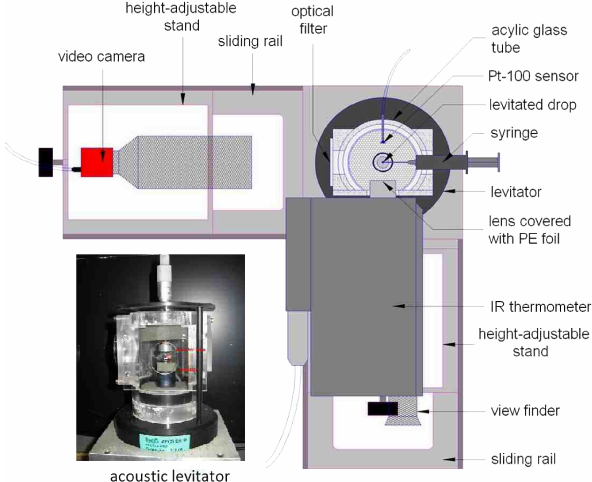
Figure 1. Scheme of the experimental setup in the cold chamber, view from above; left side: picture of the acoustic